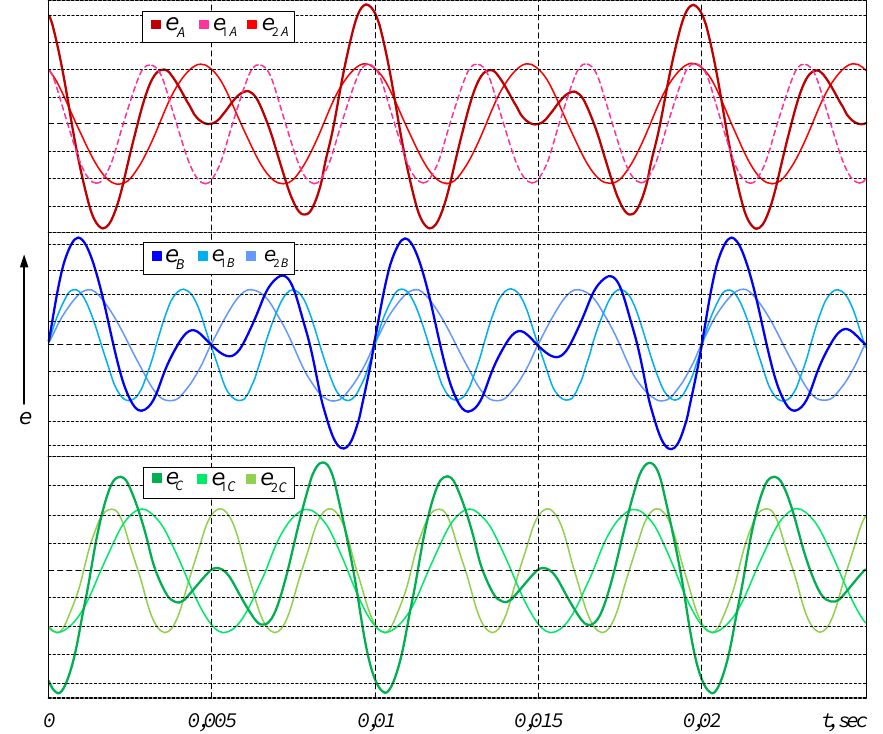
Figure. 2. Waveforms of induced EMFs and resulting EMFs of phases of armature winding of SG